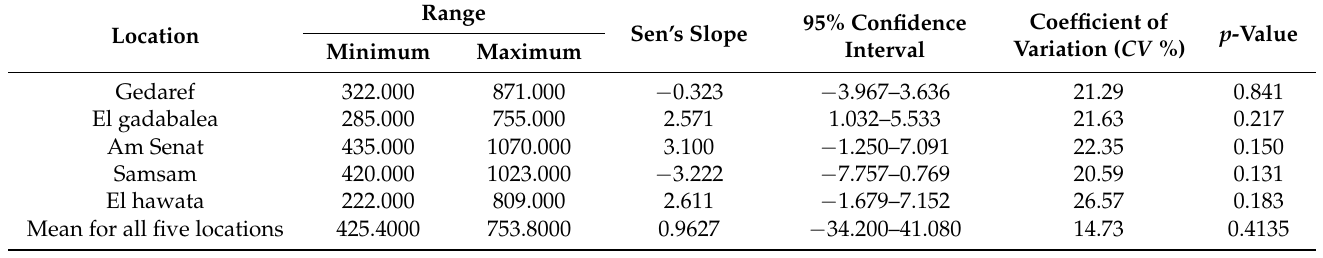
Table 2. Estimated Sen’s slope values for annual rainfall (mm) trends reported at different stations in Gedaref State, Sudan between 1980 and 2018.